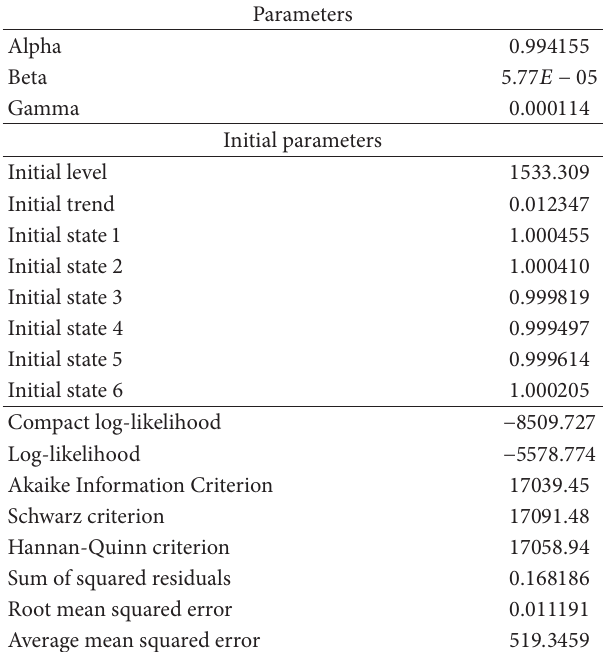
Table 5: Holt’s linear trend